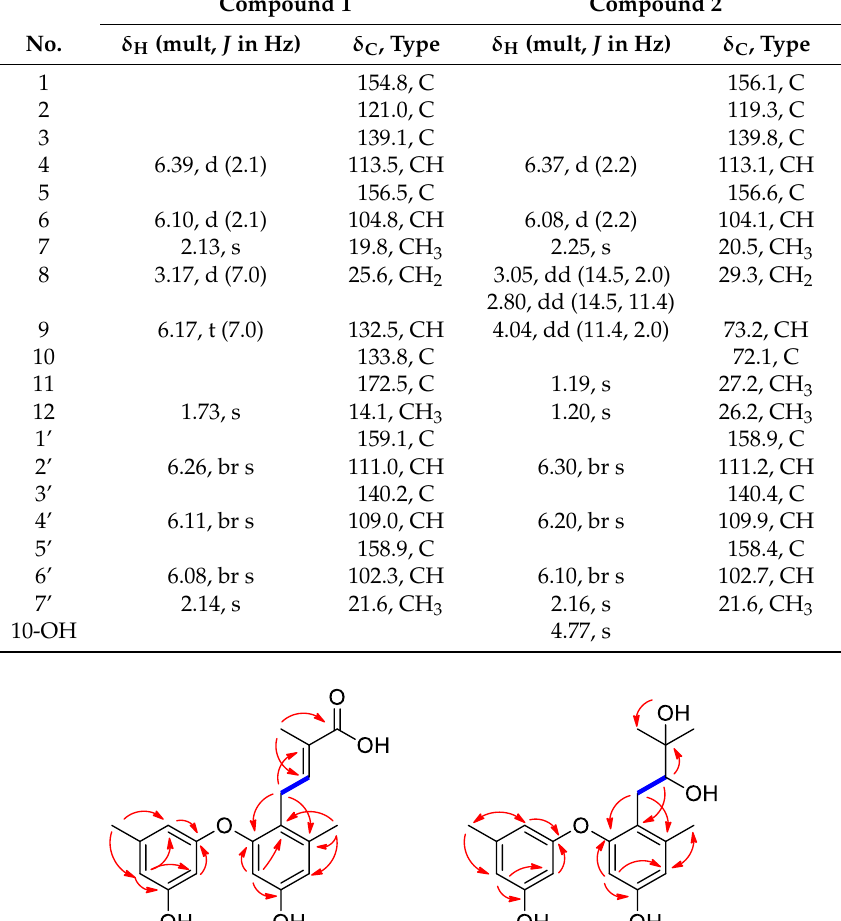
Figure 2. Key COSY (bold lines) and HMBC (arrows) correlations for compounds 1 and 2 .